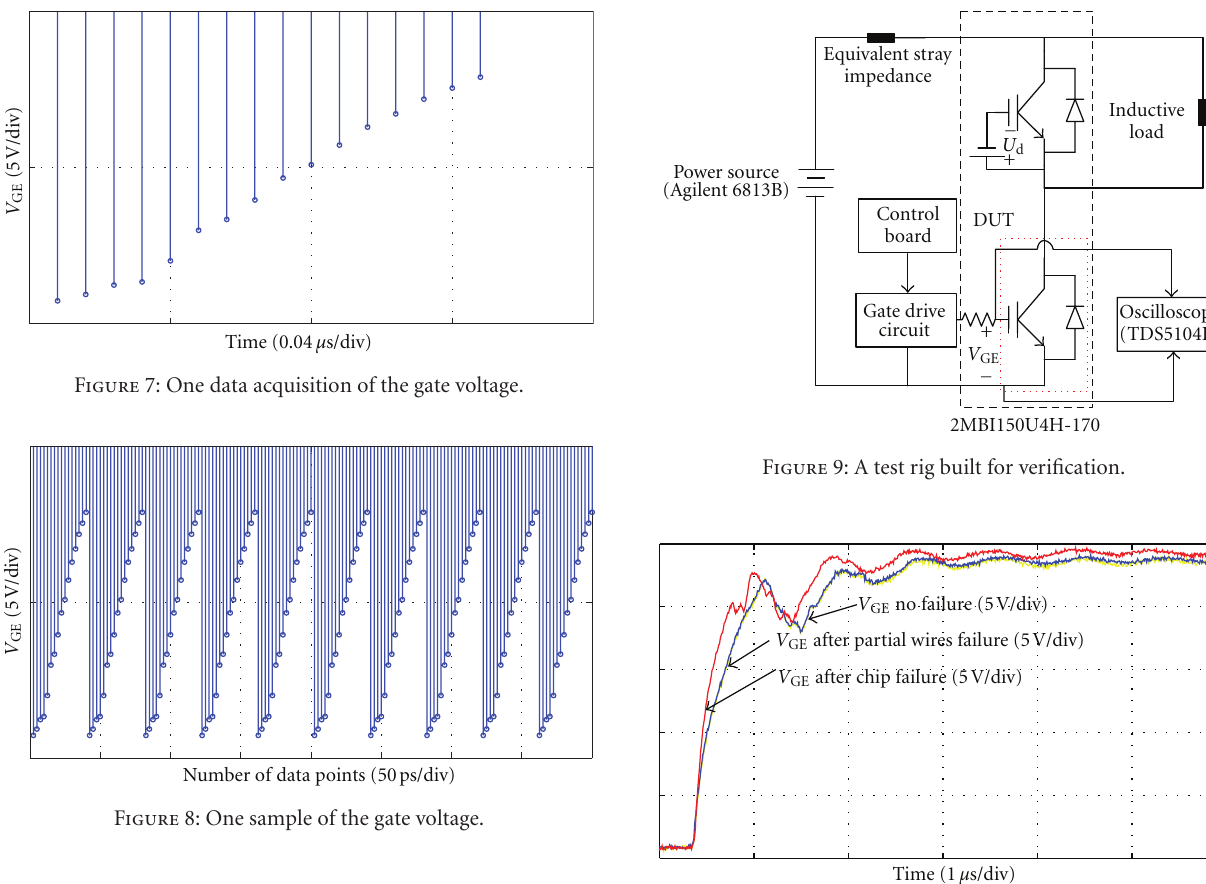
Figure 10: Turn-on waveforms of the gate voltage according to di ff erent